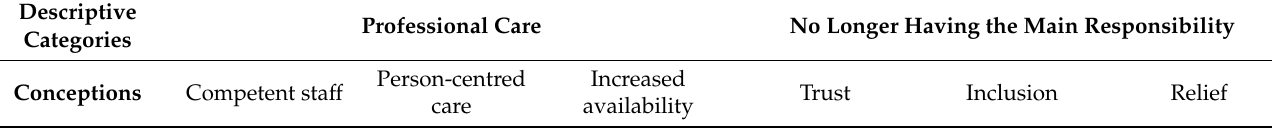
Table 2. Descriptive categories and